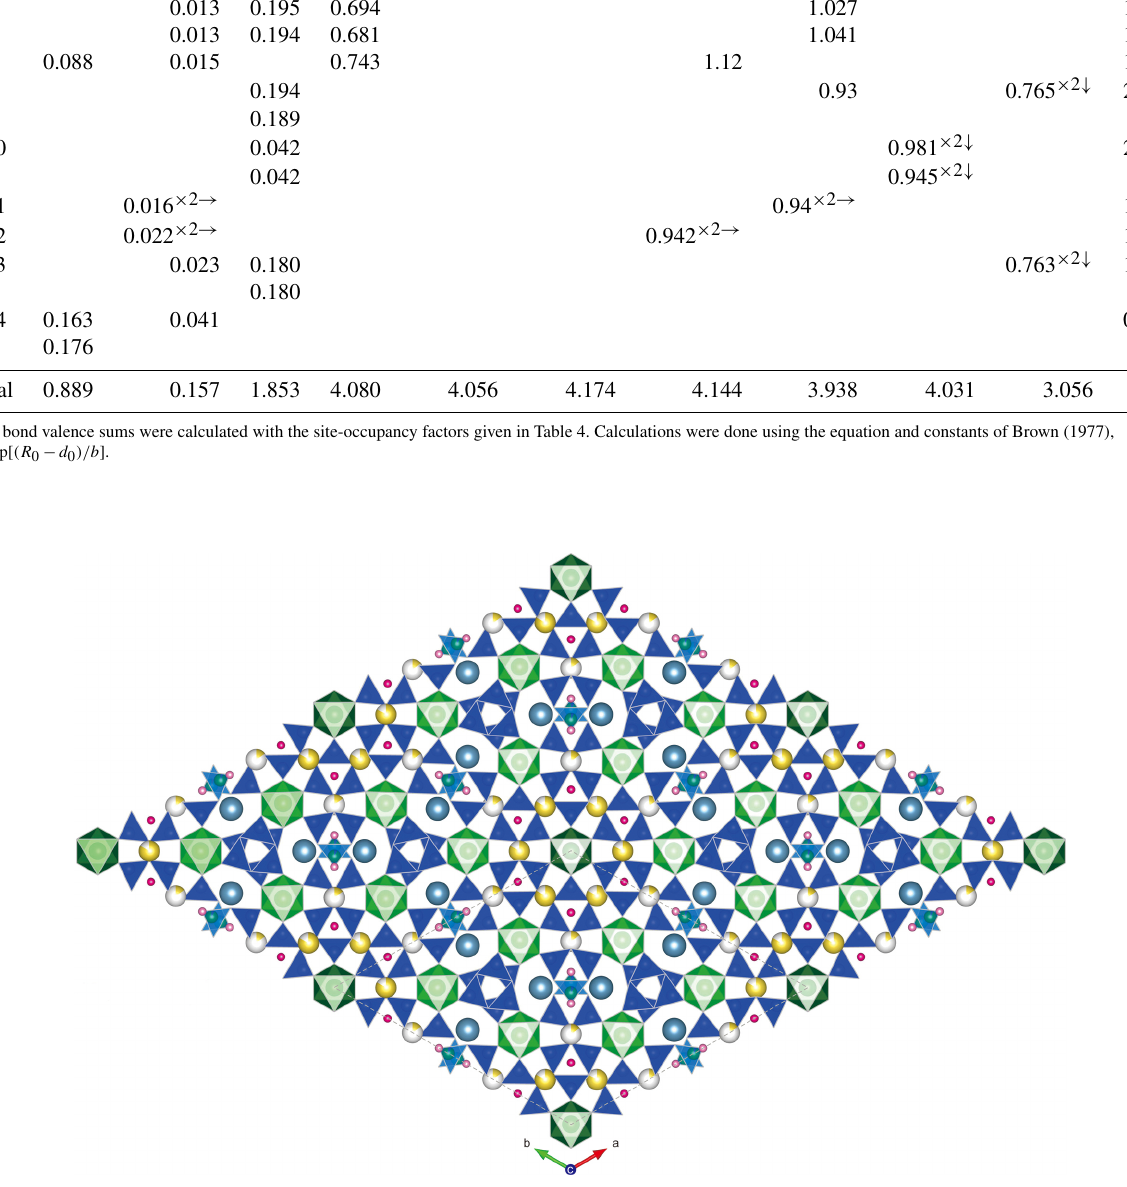
Figure 5. The giant pinwheel motif view of bobtraillite along [001] (four-unit cells, the dotted line is a single unit cell). The Zr(1)O 6 octahedra are shown in green, the Zr(2)O 6 octahedra in olive green, the SiO 4 tetrahedra in indigo, and BO 4 tetrahedra in green-blue. Other legends as in Fig.